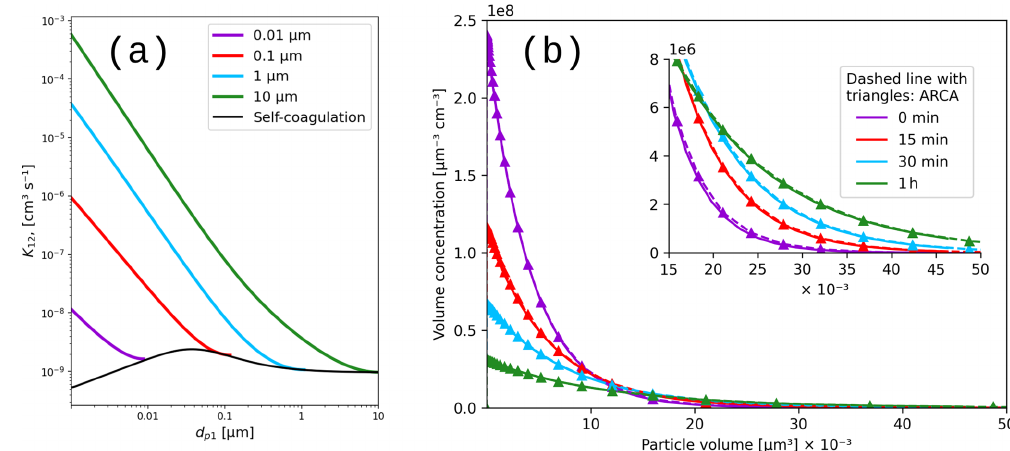
Figure 10. Coagulation coefficients used in ARCA box for four different particle diameters (a) , with sticking coefficient α g = 1. Comparison with analytical coagulation solution (b) .